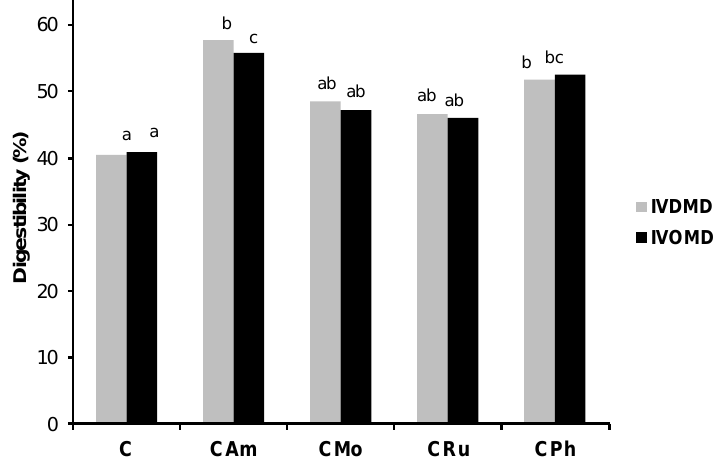
Figure 1. In vitro dry matter digestibility (IVDMD) and in vitro organic matter digestibility (IVOMD) of cocoa pod treated with chemical and biological treatments. Various superscripts above the bars within the same parameter are significantly different at p<0.01. Treatment: C, cocoa pod without any treatment; CAm, ammoniated cocoa pod with 1.5% urea; CMo, fermented cocoa pod with 3% molasses; CRu, fermented cocoa pod with 3% rumen content; CPh, fermented cocoa pod with 3% molasses and Phanerochaete chrysosporium